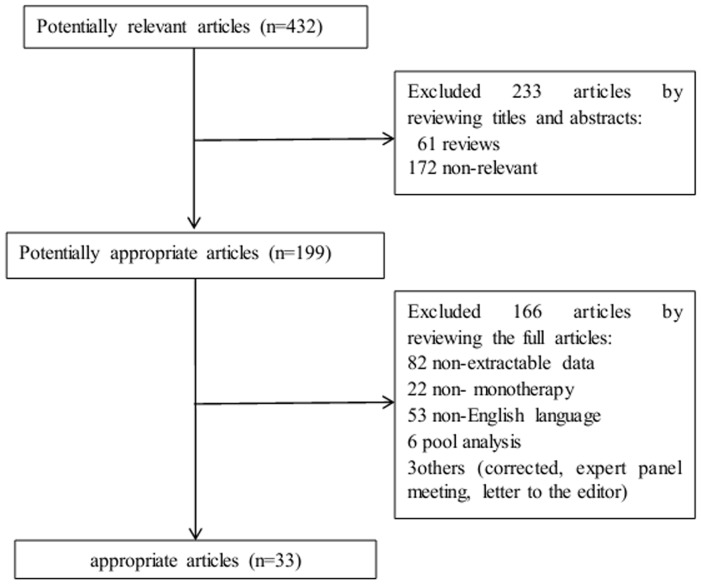
Flow chart demonstrating the progression of the trials in the review.The flowchart of selecting procedure and the exclusive reason of studies are summarized.